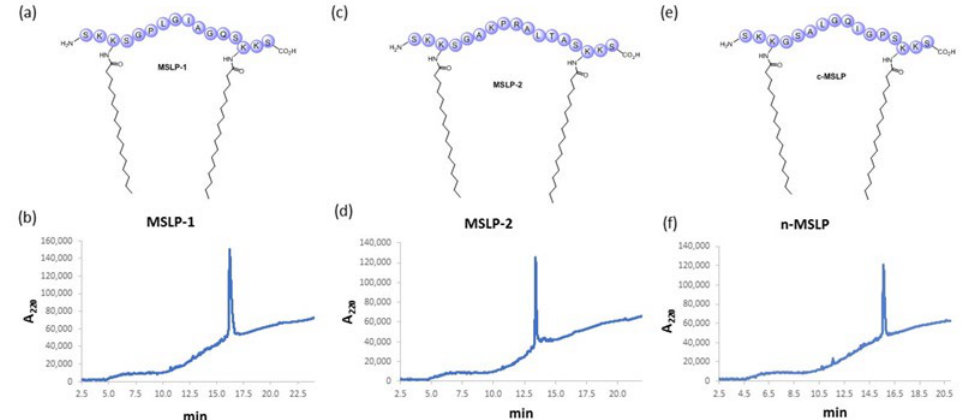
Figure 2. MSLPs molecules, characterized by a C18 alkyl hydrophobic moiety and a peptide core, corresponding to a MMP2- (MSLP-1, ( a )) and a MMP2/9-responsive sequence (MSLP-2, ( c )), and to a scrambled sequence (c-MSLP, ( e )). HPLC chromatograms of the lipopeptides (purity > 90%) are provided respectively in ( b , d , f ).